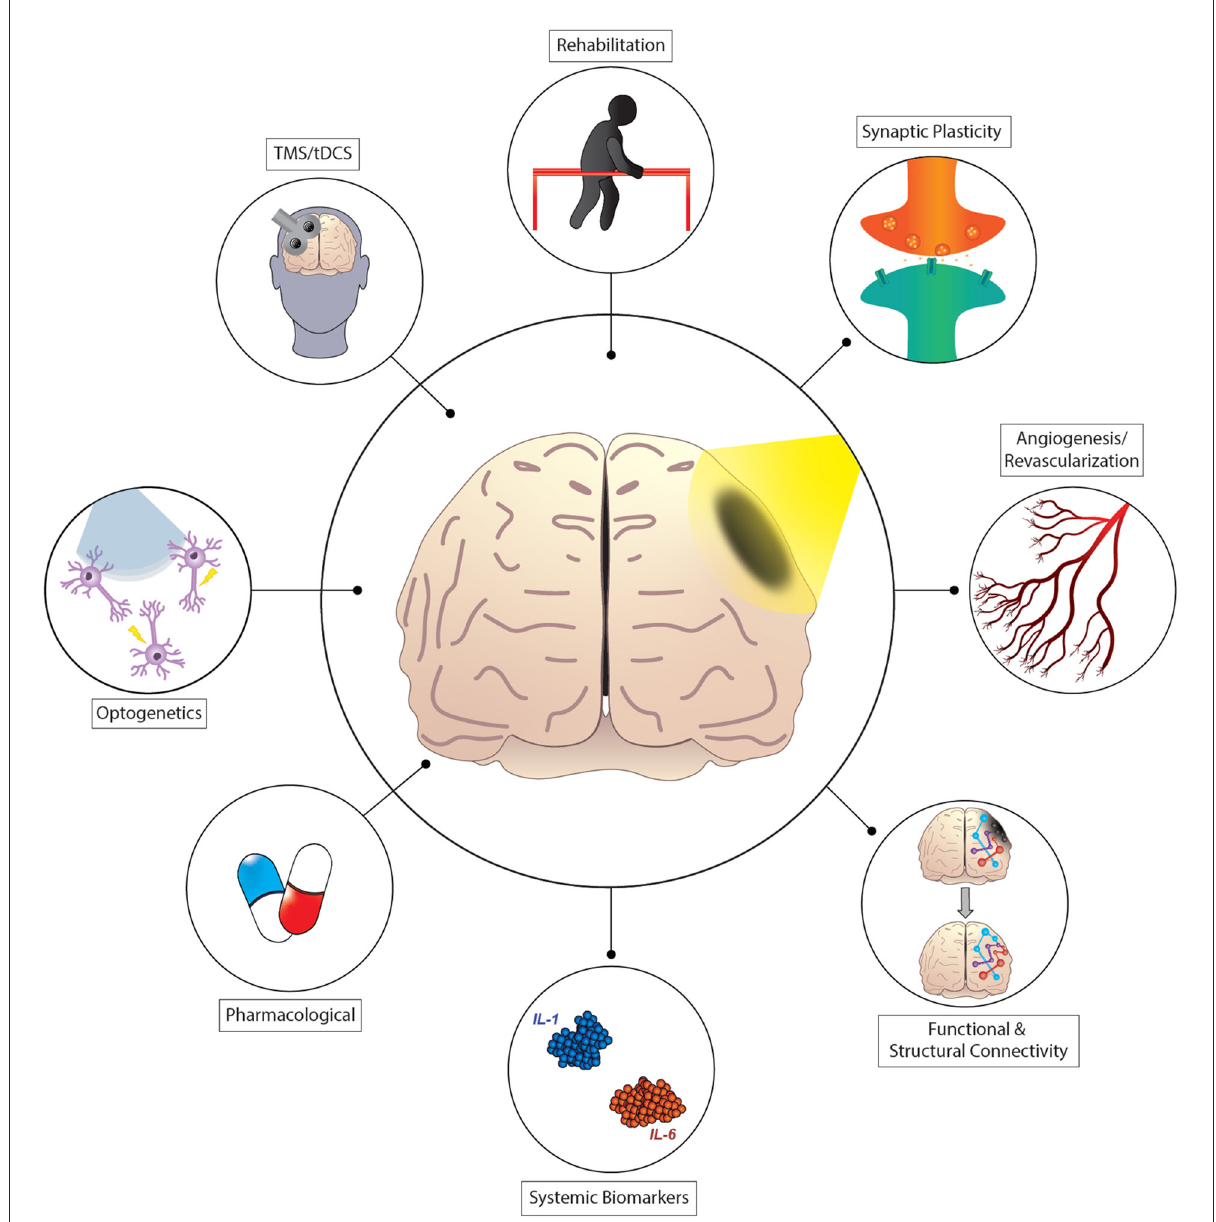
FIGURE1 Shining light on recovery after stroke. Recovery from stroke involves the formation of new or alternative structural and functional connections. These processes are facilitated by changes in the expression of genes affecting neuronal plasticity, angiogenesis, and other mechanisms. Interventional strategies designed to affect recovery processes include physical therapy, pharmacological treatment, or brain stimulation techniques such as transcranial magnetic stimulation, direct current stimulation (TMS/tDCS), and optogenetic targeting